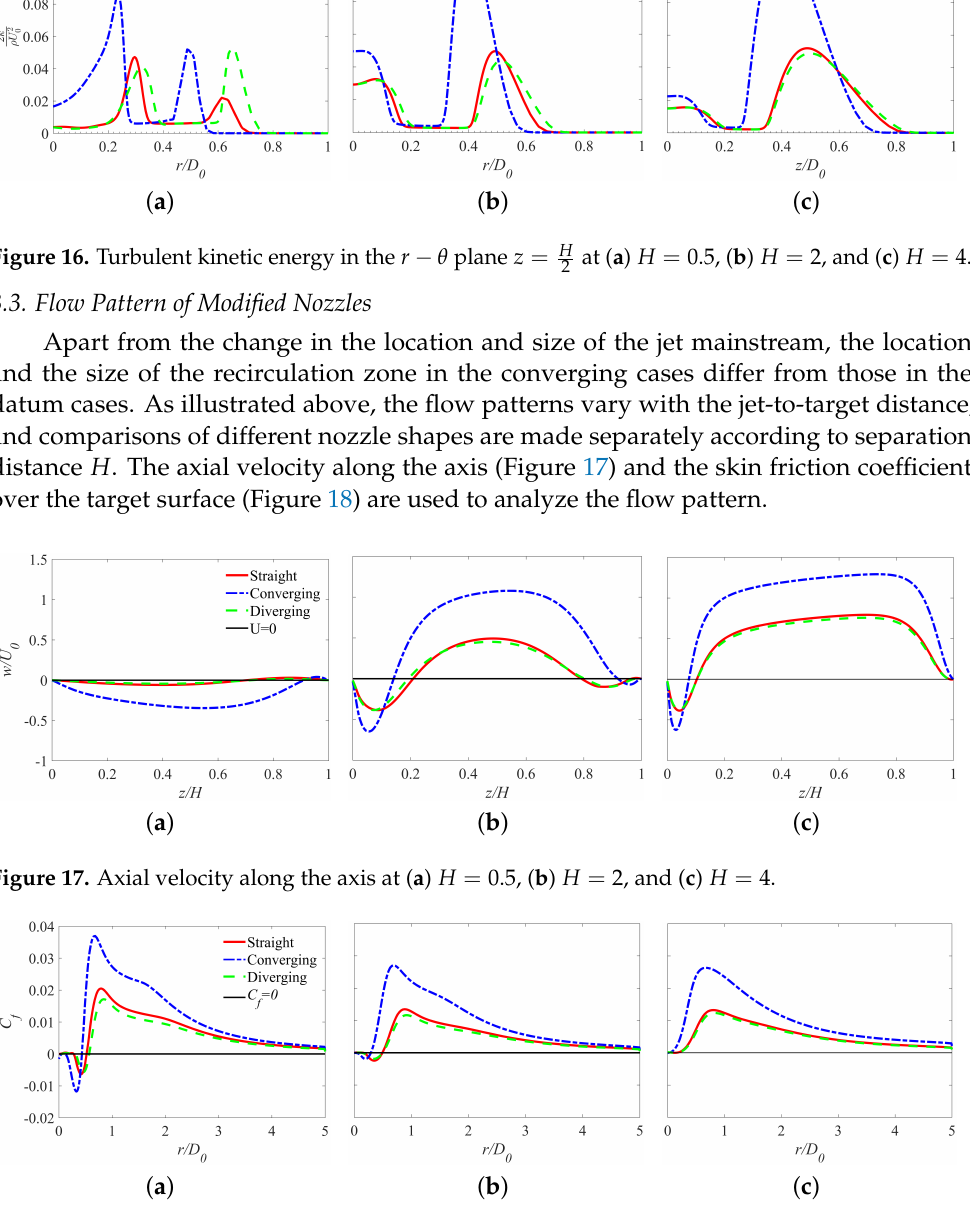
Figure 16. Turbulent kinetic energy in the r − θ plane z = H